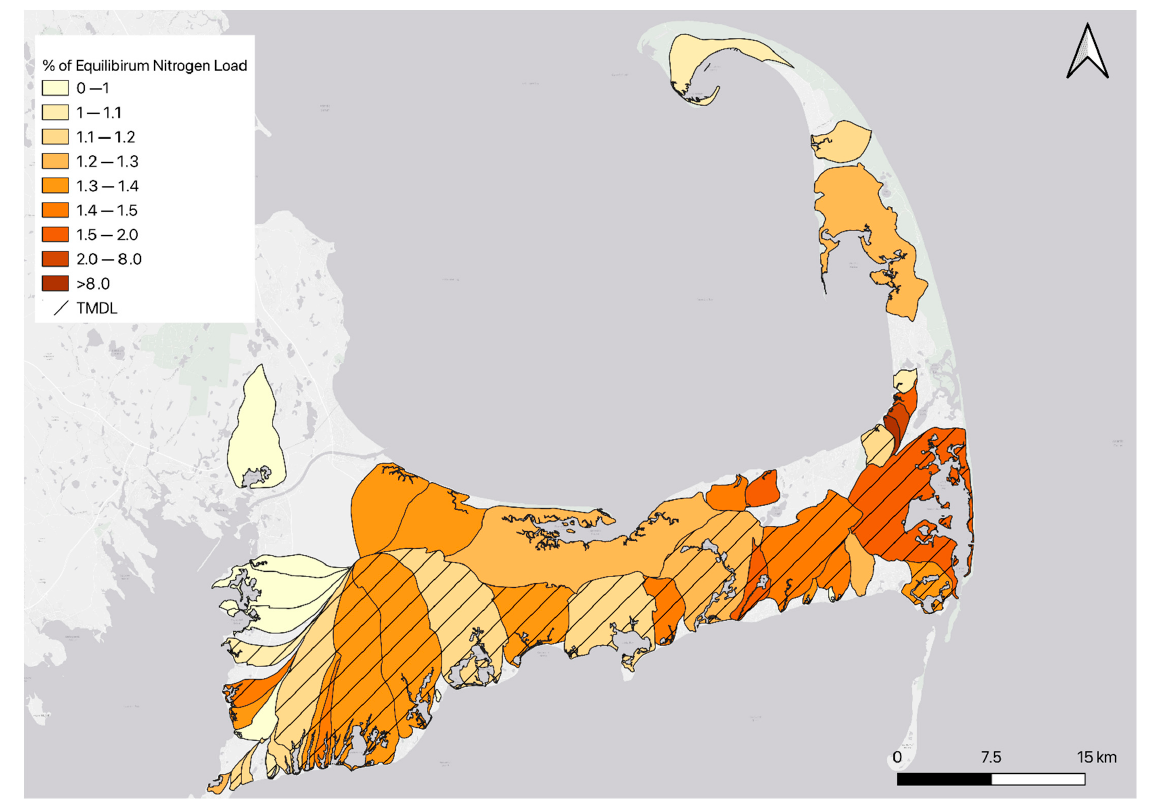
Figure 3. Map of the watersheds for each embayment. Watersheds in watershed loading equilibrium are indicated in pale yellow. Those not in equilibrium are shaded from light orange to dark brown based on their expected increase in N loading above current conditions (see legend). Watersheds with TMDLs are indicated with cross-hatching.